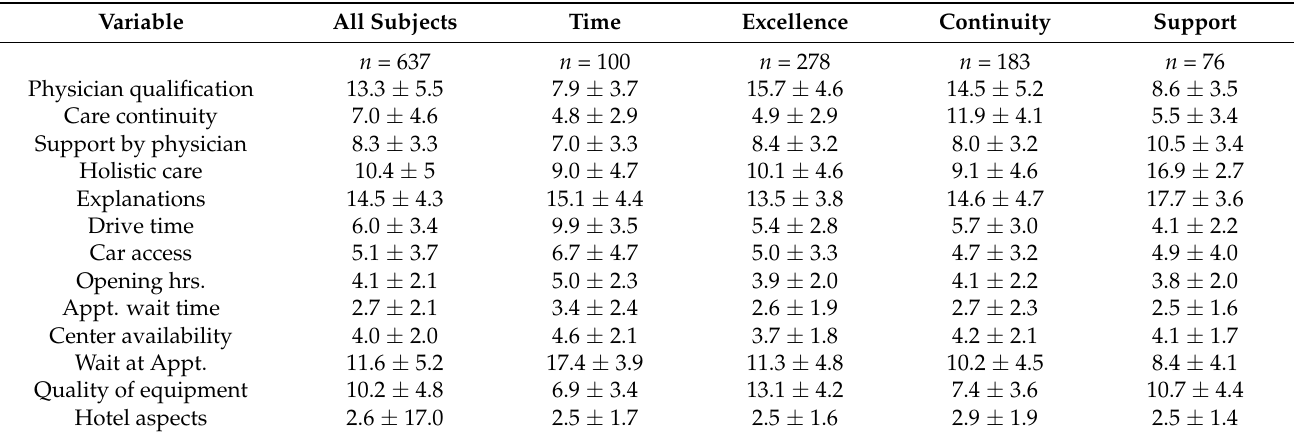
Table 1. Overview of the distribution of the mean ± standard deviation of the 13 characteristics by patient cluster. Appt., appointment; hrs.,